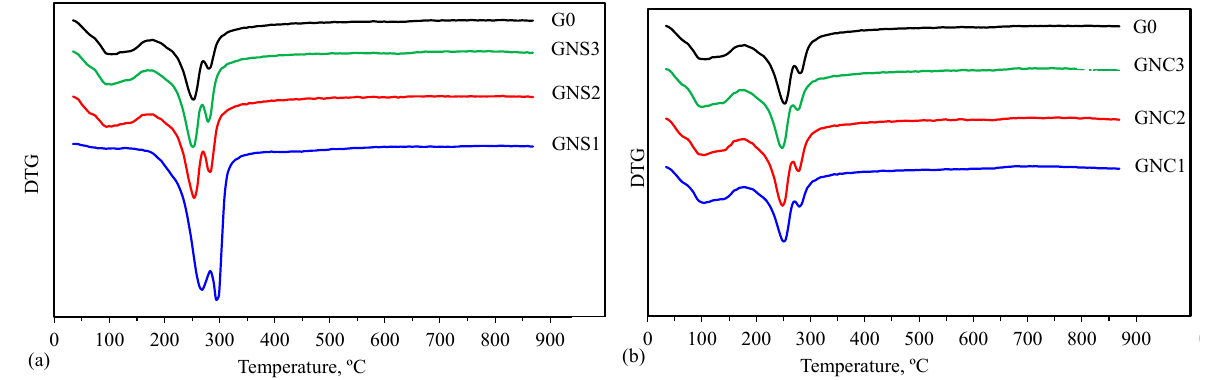
Figure 11. DTG curves for cement pastes containing NS ( a ) and NC ( b ).